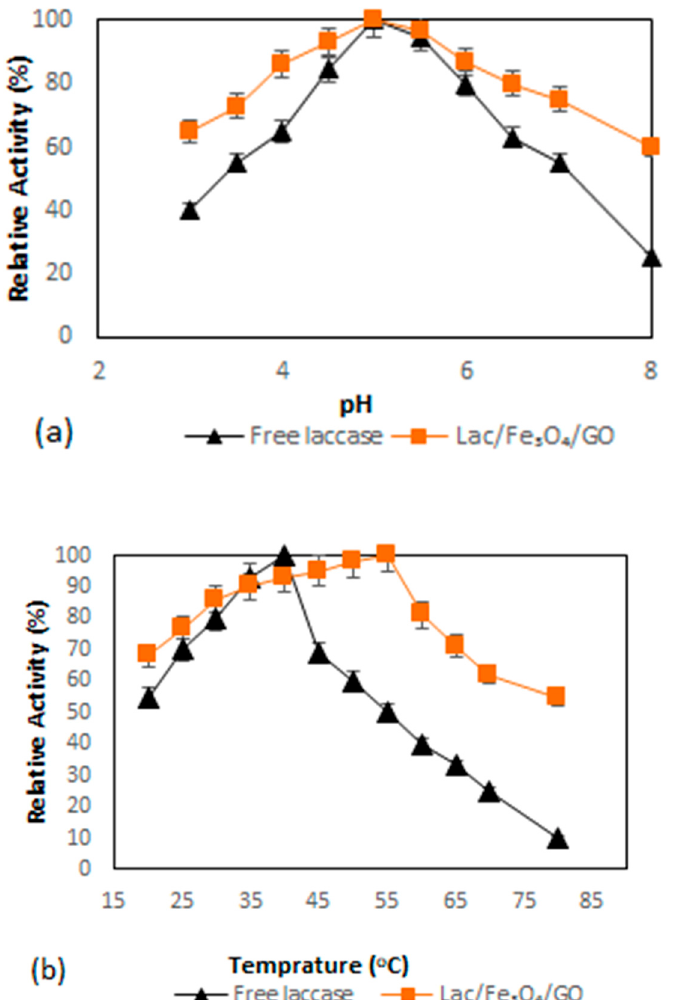
Figure 3. ( a ) Effect of pH on the activity of the free laccase and Lac/Fe 3 O 4 /GO (Na–acetate buffer for pH = 3–5 and Na–phosphate buffer for pH = 6–8) by the ABTS aerobic oxidation reaction at room temperature for two hours. ( b ) Effect of temperature on free laccase and Lac/Fe 3 O 4 /GO. The relative activity was determined at various temperatures at pH = 5 by ABTS aerobic oxidation reaction. All experiments were performed in triplicate. The error bars were determined (5%).